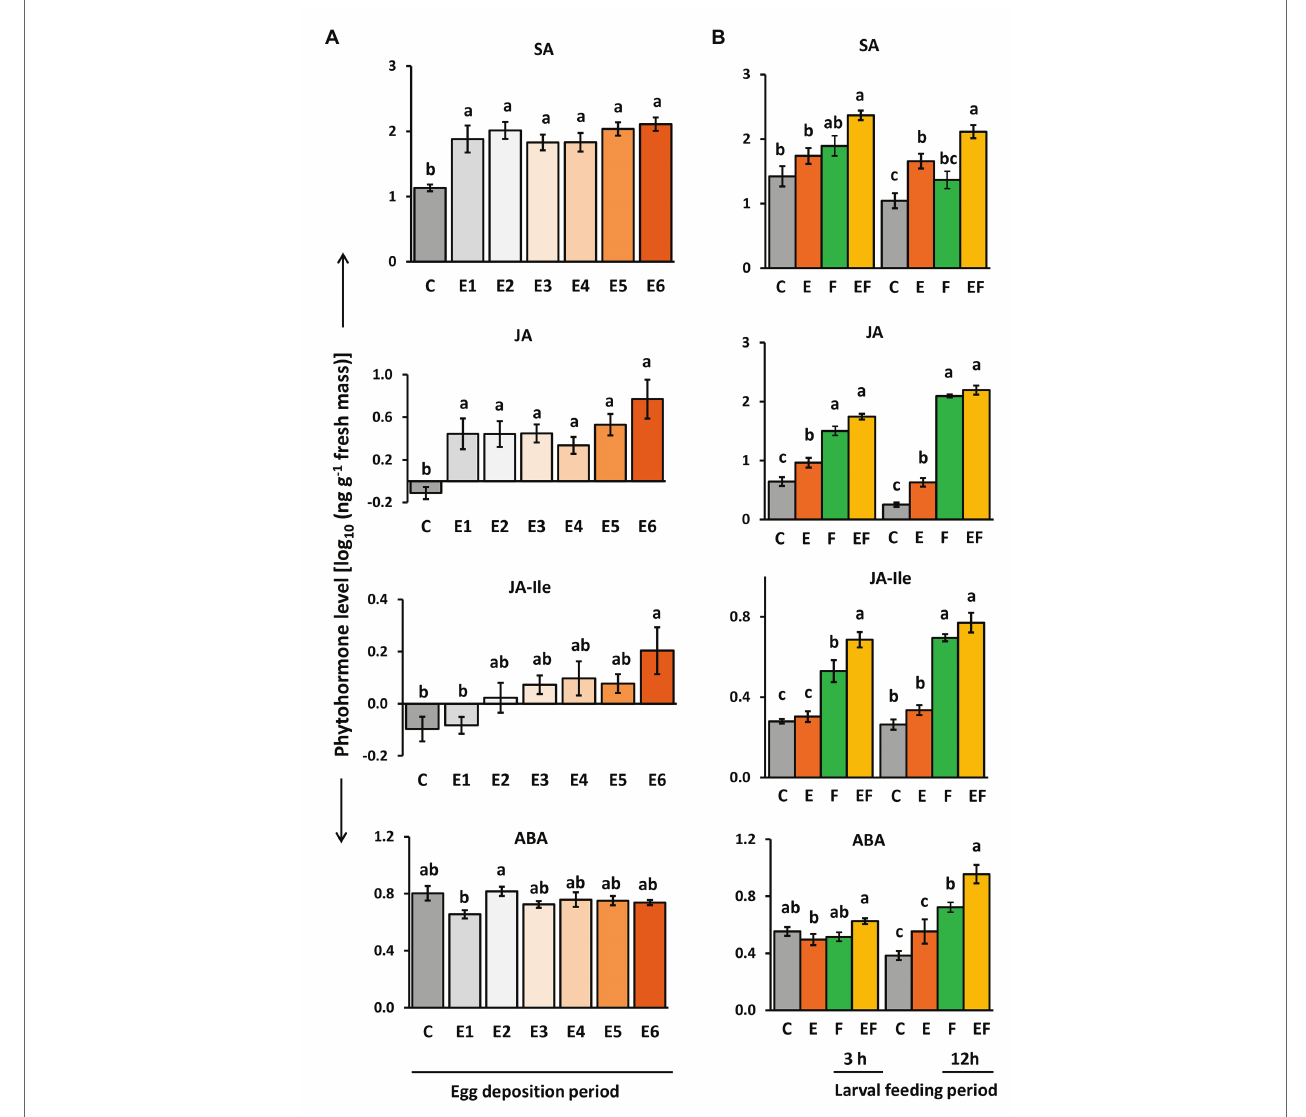
FIGURE 4 | Impact of P. brassicae egg deposition on phytohormone levels of non-damaged and larval feeding-damaged Arabidopsis thaliana leaves. (A) Impact of P. brassicae egg deposition period on phytohormone levels and (B) impact of 6 days lasting egg deposition on phytohormone levels after a 3 h or 12 h larval feeding period. (A) Phytohormone levels in egg-free control plants (C) or in plants exposed to eggs for 1 day (E1), 2 days (E2), 3 days (E3), 4 days (E4), 5 days (E5), or 6 days (E6). (B) Phytohormone levels in untreated control plants (C), for 6 days egg-laden plants and subsequent egg removal (E), 3 h or 12 h larval feeding-damaged plants without prior egg deposition (F) and with prior egg deposition for E6 (EF). Concentrations are log 10 -transformed in ng g −1 fresh weight (mean ± SE). From top to down: levels of salicylic acid (SA), JA, JA-isoleucine (JA-Ile), and ABA. Different letters indicate significant differences between treatments ( p < 0.05, linear mixed model and post hoc general linear hypothesis test with Tukey contrasts). Biological replicates (plants) per treatment: N =